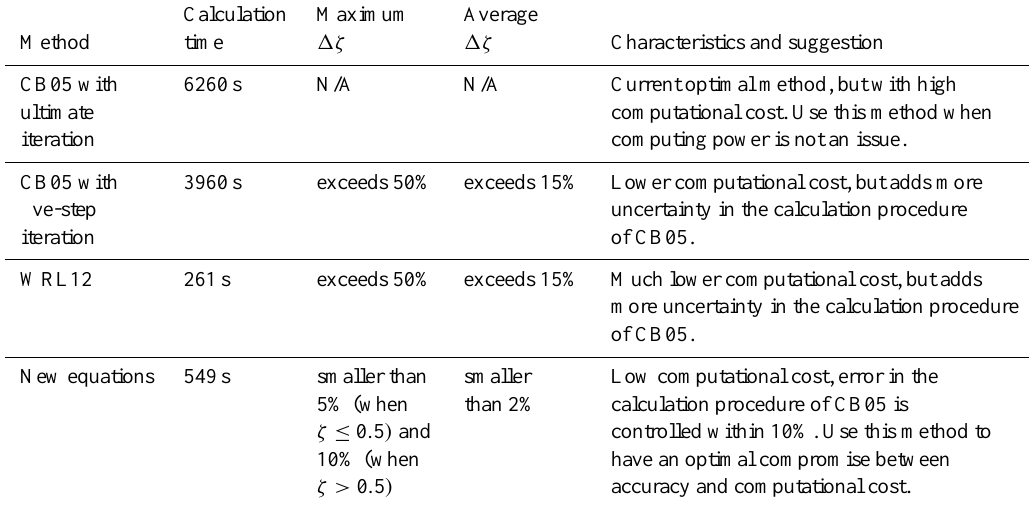
Table 11. Summarization of the characteristics of the four methods. Calculation time is the time each method needs for computing ζ from Ri B , z 0 and z 0 h in the range 0 < Ri B ≤ 2 . 5, 10 ≤ z/z 0 ≤ 10 5 and − 0 . 5 ≤ log (z 0 /z 0 h ) ≤ 30 with the interval of 0.01 for Ri B , 0.035 for log (z/z 0 ) and 0.1 for log (z 0 /z 0 h ) . The calculation is performed on a desktop computer with an Intel Core i5 processor, and note that the calculation time can vary with different computer.